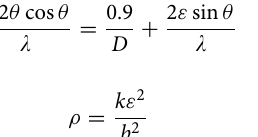
where θ is the diffraction angle, Δ2 θ is the full width at half maximum (FWHM) of the diffraction peak, λ is the wavelength of the incident X-ray beam, ε is the heterogeneous strain, D is the crystallite size, and b is the magni- tude of Burgers vector (0.2556 nm for the present high-Mn steel). k is a constant related to the crystal structure, which is 16.1 for the FCC structure 70 . ε and D are evaluated from the slope and intercept of the obtained line in the Williamson-Hall plot according to the Eq. (2).